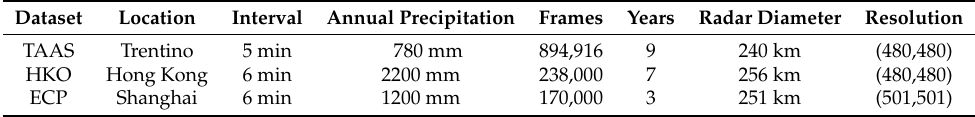
Table 2. Summary of three precipitation